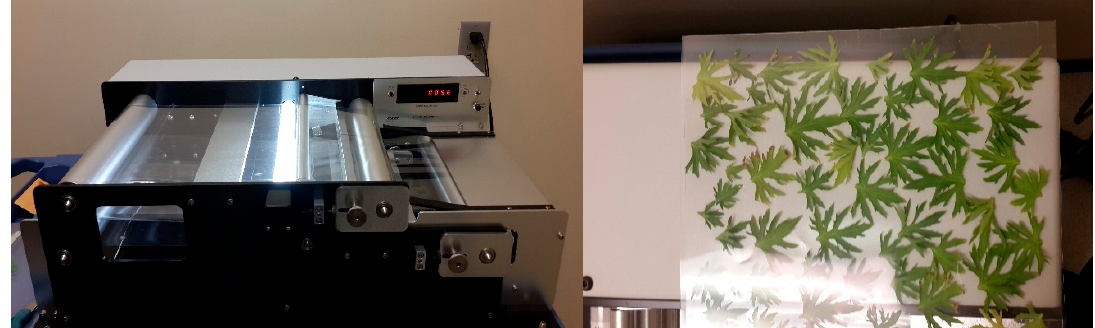
Figure 6. L1-3100C Area Meter ( left ), used to measure the leaf coverage area ( right ).